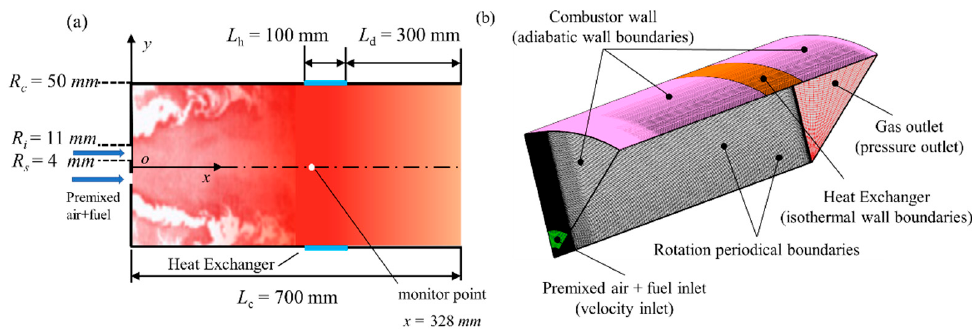
Figure 1. ( a ) Diagram of computational domain and key geometry parameters, and ( b ) mesh generation of the 1/8th sector combustor.